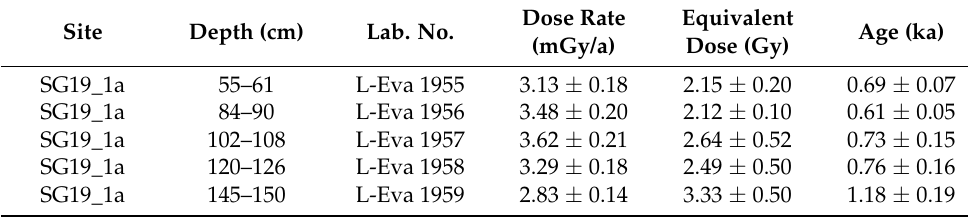
Table 2. Results of OSL